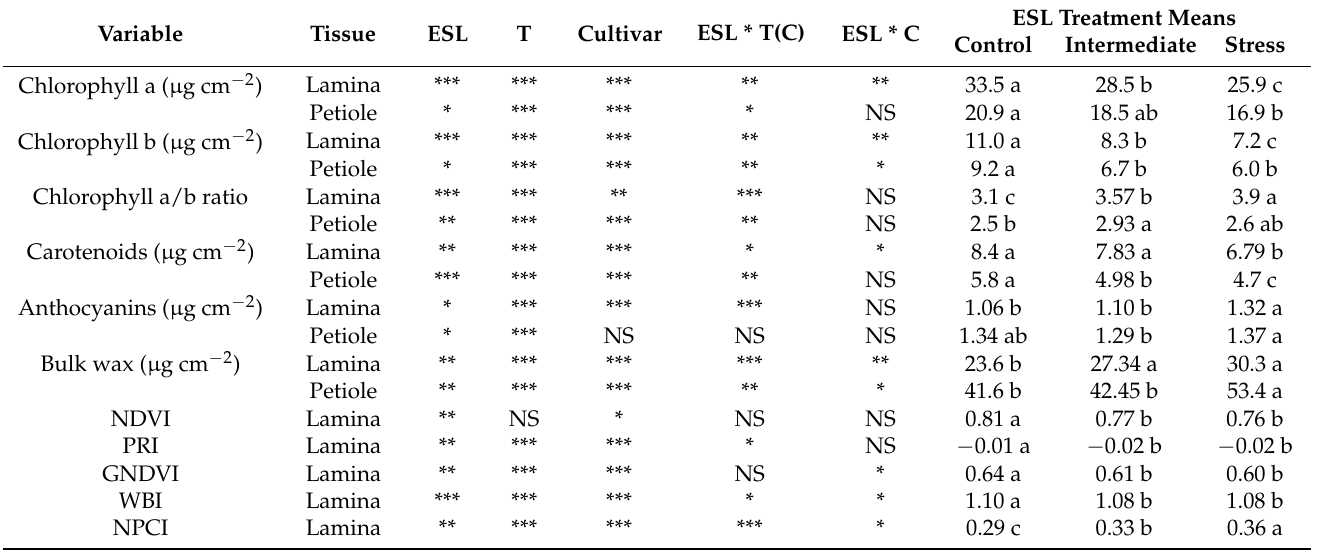
Table 2. Univariate analysis of variance (ANOVA) results showing significance of cultivar, environ- mental stress level (ESL), canopy type (T) main effects and their interactions on leaf pigments, wax, and vegetation indices of 24 pea cultivars grown across six environments at Rosthern and Saskatoon, 2014–16. Means of traits are presented for the three stress levels of control, intermediate, and stress. The control ESL are 2014 late seeding date at Rosthern and 2016 normal seeding date at Saskatoon; intermediate ESL are 2014 and 2016 late seeding date at Saskatoon; and stress ESL are 2015 late seeding date at Rosthern and Saskatoon,